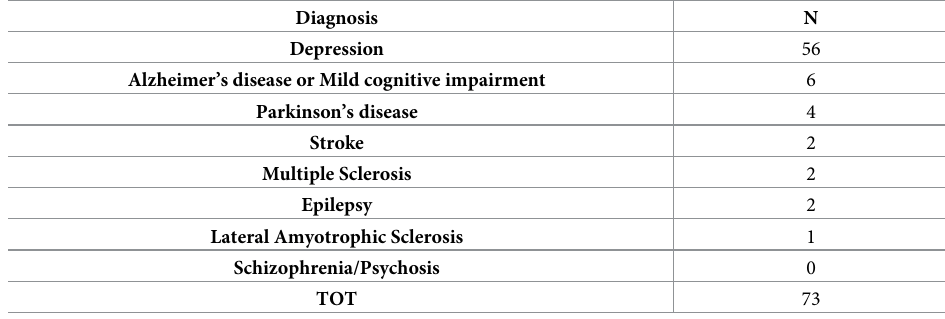
Table 8. Frequency of participant’s new medical conditions that represent an endpoint for the study.